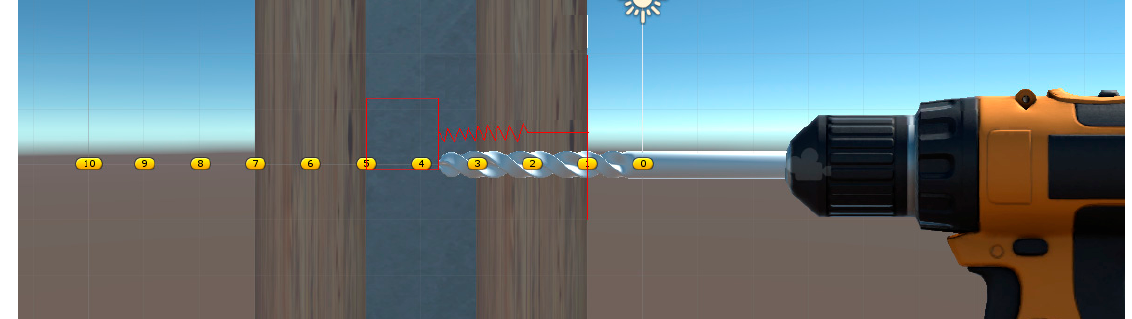
Figure 4. Spring–mass layered model for the Touch 3D Stylus haptic device.